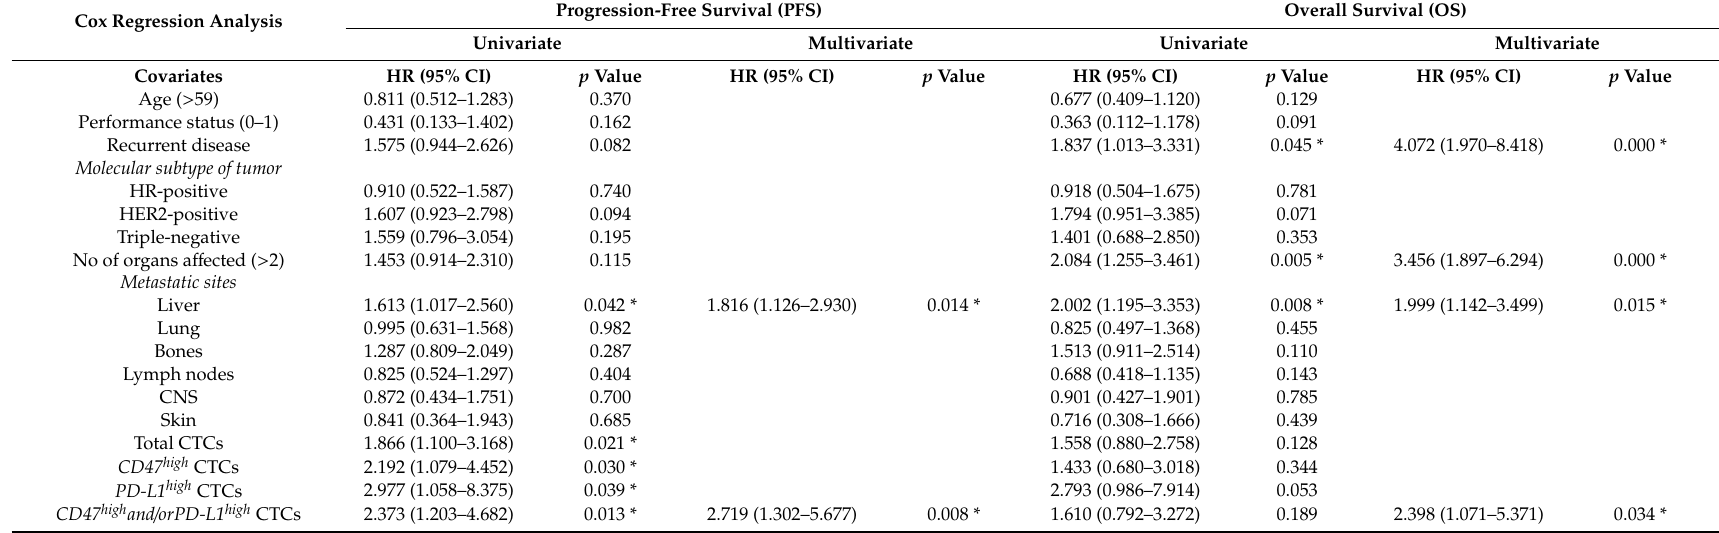
Table 4. Univariate and multivariate Cox-regression analysis for PFS and OS among patients with metastatic